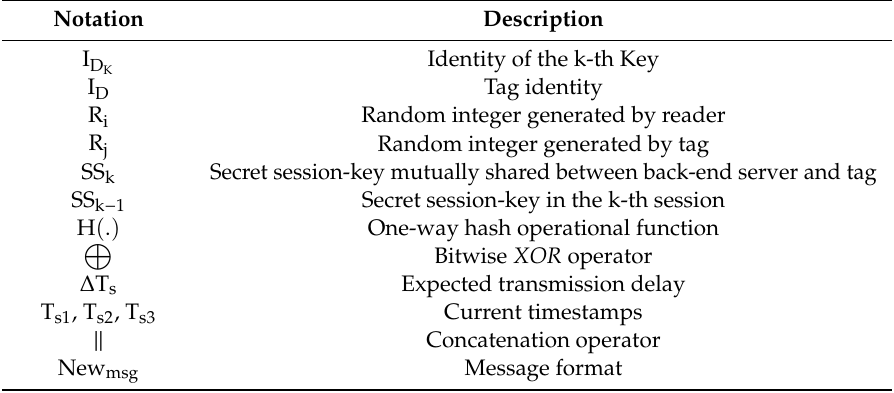
Table 2. Important notations